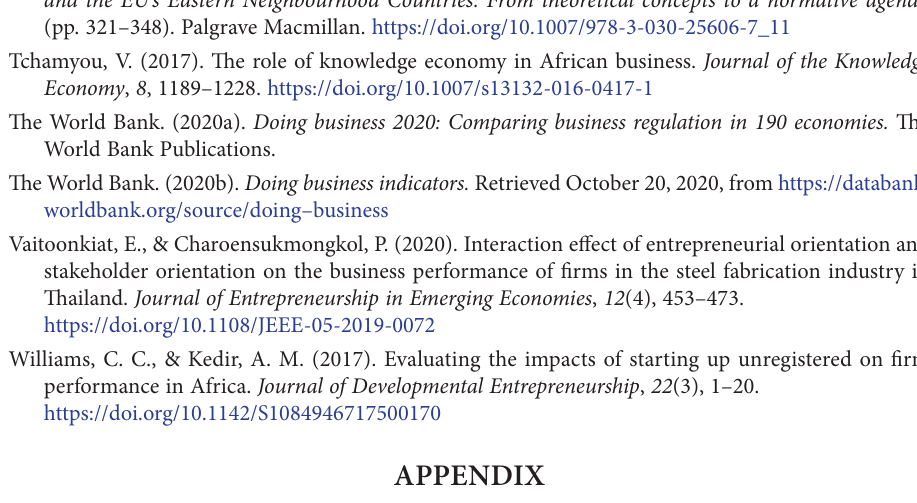
Table A1. Variables used in the study (source: authors’ calculation) No. Variable used